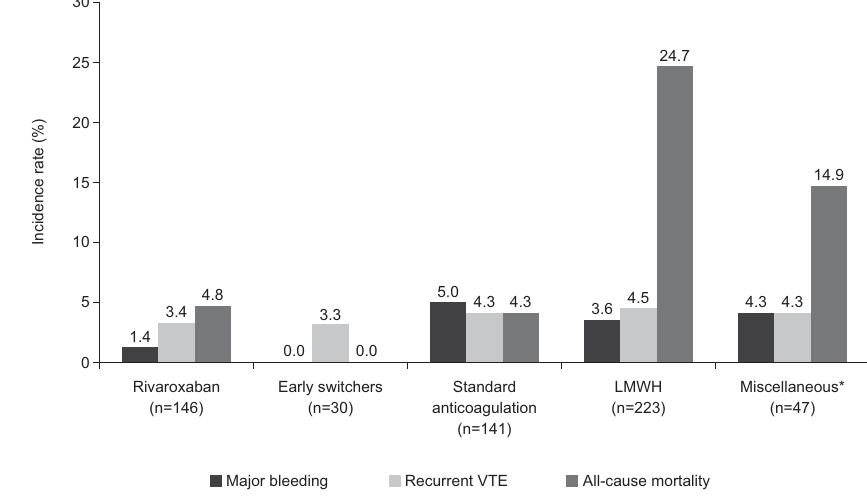
Fig. 2 Primary outcomes in patients with cancer by treatment group. Outcomes are unadjusted for imbalances in clinical characteristics at baseline, and cannot be directly compared between treatment cohorts. (cid:4) Miscellaneous cohort included patients treated with other heparins, fondaparinux alone, or a VKA alone. LMWH, low-molecular-weight heparin; VKA, vitamin K antagonist; VTE, venous